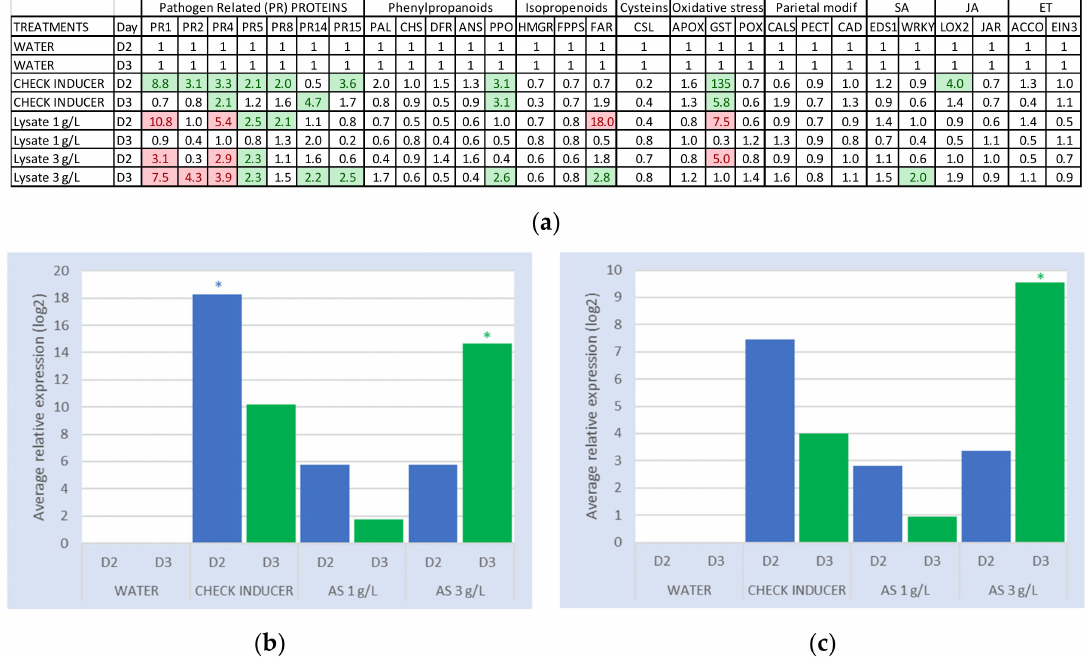
Figure 1. Elicitor e ff ect of the active substance (AS): ( a ) Fold change represents relative gene expression values (2 − ∆∆ Ct) of the defense genes (qPFD ® ) in grapevine, compared to the water control. Values superior or equal to 2 are in green (moderate inductions), and the ten highest values of the lysate data are in red (high inductions). Assessment of the candidate product at two doses, compared to the internal check inducer, at two (D2) and three (D3) days after treatment (D0). A H 2 O 2 application was performed 24 h later (D1) in order to mimic a pathogen attack. The average relative expressions were obtained by RT-qPCR from two independent repetitions and relative to the water control at each sampling date. The results are the average of the relative expressions of genes from two independent repetitions. SA, salicylic acid; JA, jasmonic acid; ET, ethylene. Complete gene names are provided in Table 1. ( b ) The cumulation of inductions (log2 relative expressions > 0) of the 28 defense genes in the grapevine qPFD ® , for amoeba lysate compared to the internal check inducer, at the sampling dates D2 and D3. The sum of inductions represents that the sum of the average relative expressions (log2 (2 − ∆∆ Ct)) is higher than zero for the 28 genes, relative to the water control, at each sampling date. ( c ) Cumulation of inductions (log2 relative expressions > 0) of the pathogen-related (PR) protein genes from the grapevine qPFD ® , for amoeba lysate compared to the internal check inducer, at the sampling dates D2 and D3. The sum of the inductions represents the sum of the average relative expressions (log2 (2 − ∆∆ Ct)) of the PR protein genes with values higher than zero, relative to the water control, at each sampling date. *: p <